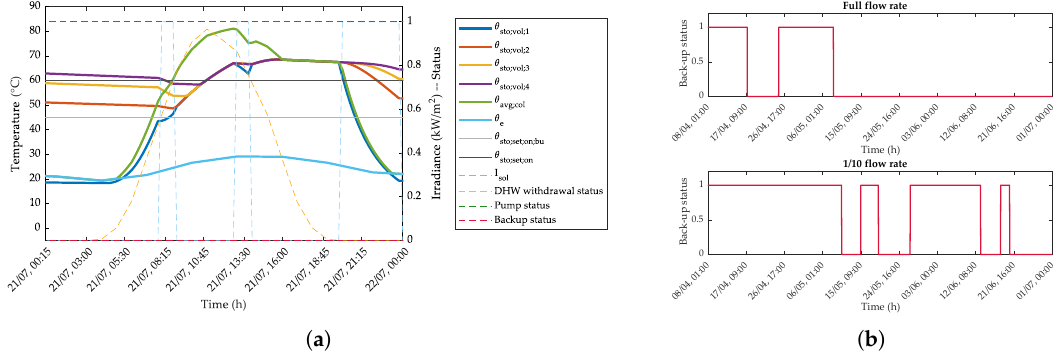
Figure 11. The effect of lower flow rate ( a ) on system temperatures in a hot summer day, and ( b ) over the back-up switch-off in spring mid-season. Time step: 15